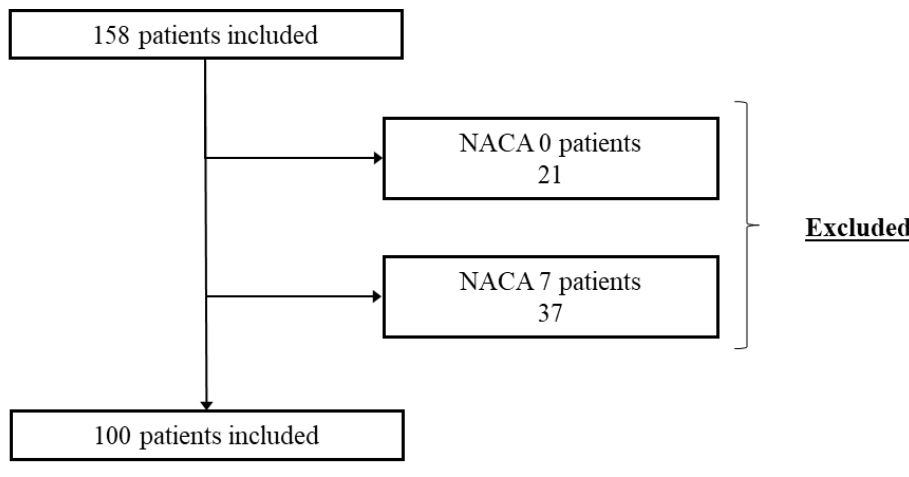
Figure 2. Overview of NACA Figure 2. O verview of NACA scores.